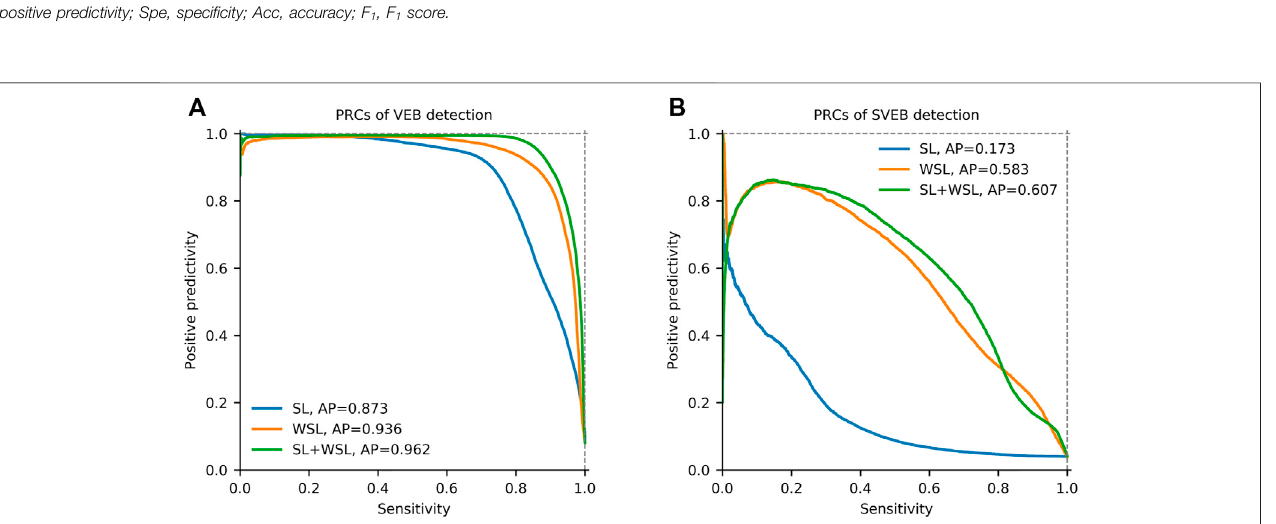
Frontiers in Physiology |